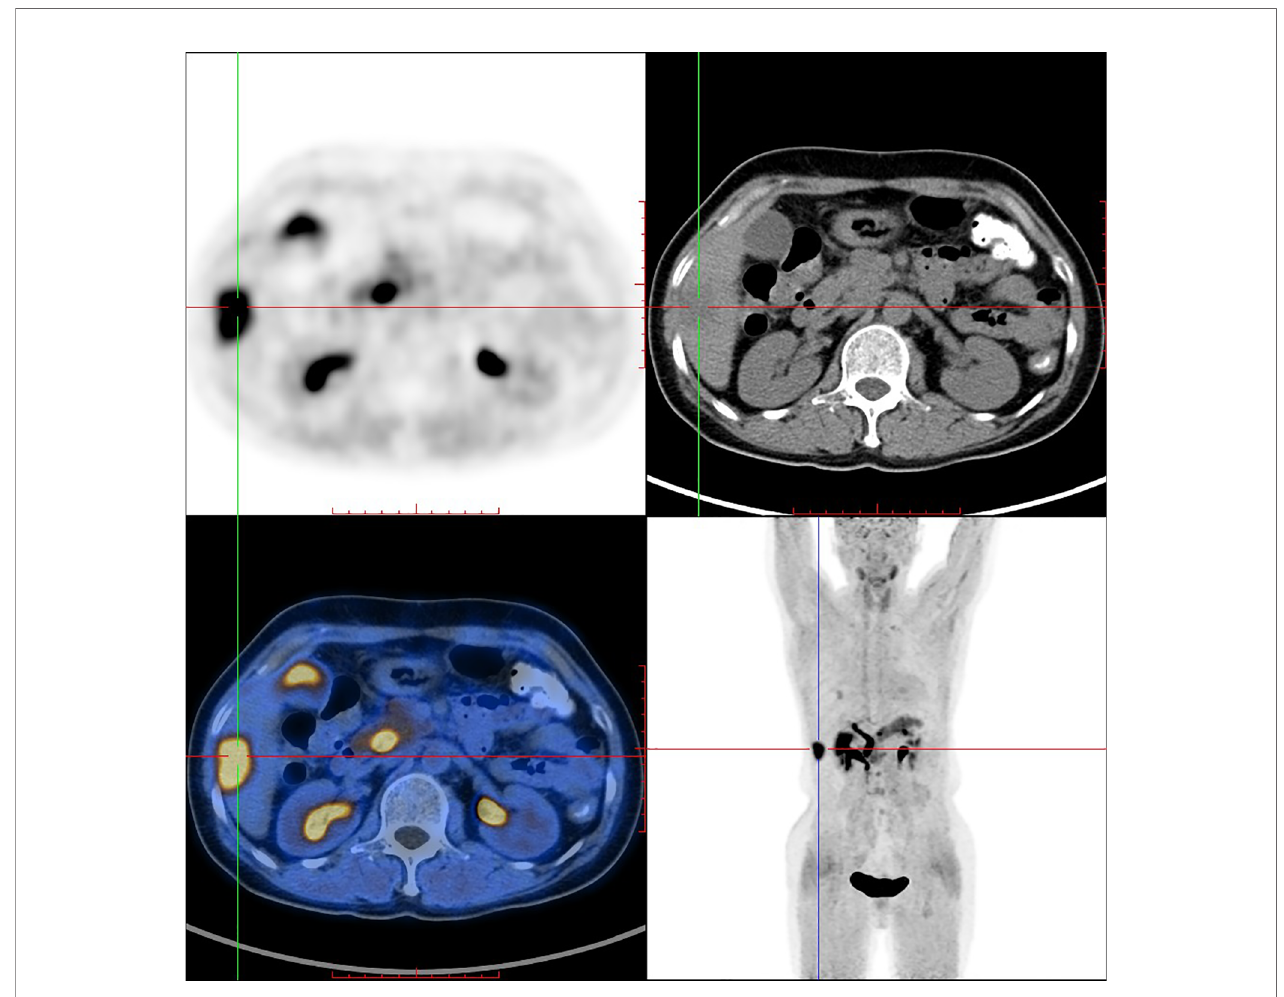
FIGURE 5 | [ 18 F]AlF-NOTA-FAPI-04 PET/CT imaging of a female IDC patient (54